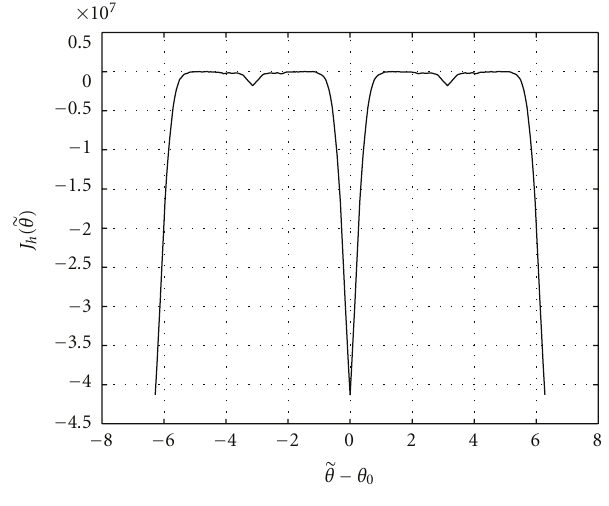
Figure 3: J h ( (cid:2) θ ) versus the phase o ff set estimation error ( (cid:2) θ − θ 0 ).